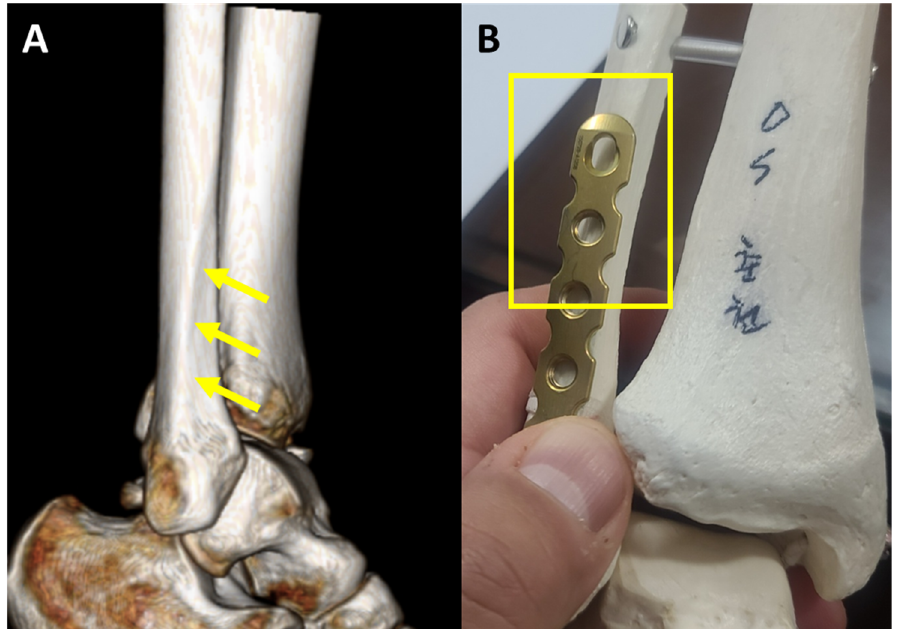
Figure 1. ( A ) Morphology of distal fibula presenting an interosseous crest (arrows), dividing anterior and lateral surface of the fibula. ( B ) Proximal portion of the two-dimensionally contoured plate is not fit on the bone surface (square box).